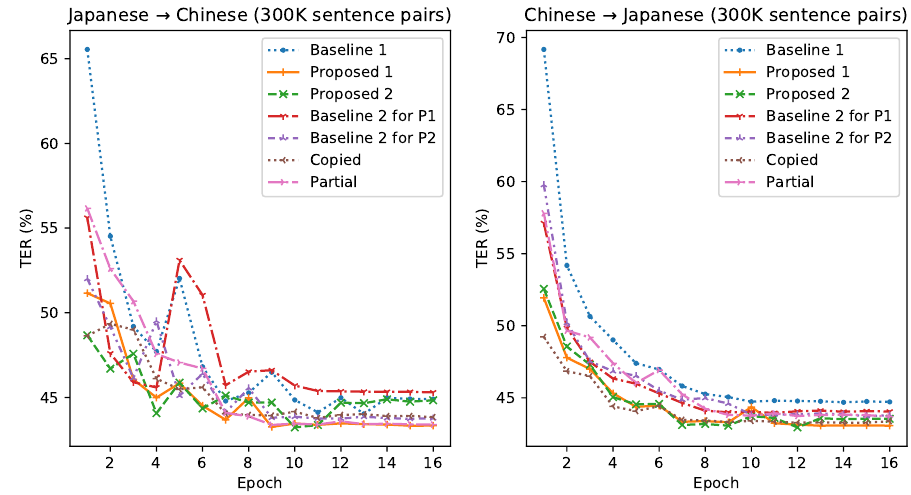
Figure 6. Translation Error Rate (TER) scores on the test data of 300k sentences. “P1” denotes the Proposed 1 method, “P2” denotes the Proposed 2 method.